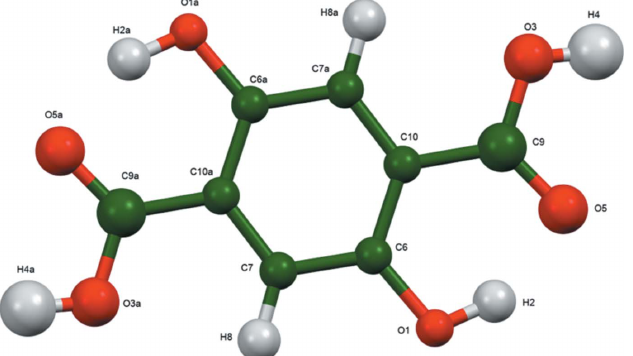
Figure 3 The full 2,5-dihydroxyterephthalic acid molecule, with the atom numbering. The atoms are represented by 50% probability spheroids. Image generated using Mercury (Macrae et al. , 2020). Symmetry code: ( a ) 1 (cid:4) x , 1 (cid:4) y , 1 (cid:4) z .